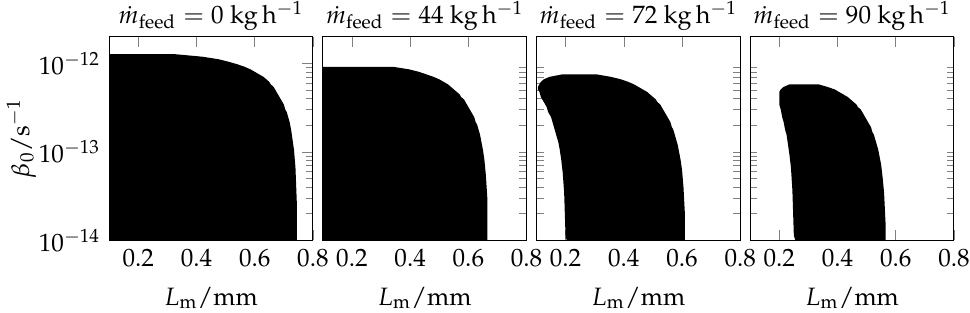
Figure 9. Stable (white) and unstable (black) regions for variations of the external particle feed rate. The quality of the product particles is mainly determined by their average diameter and its variation which can be improved by varying the sieving diameter if required.